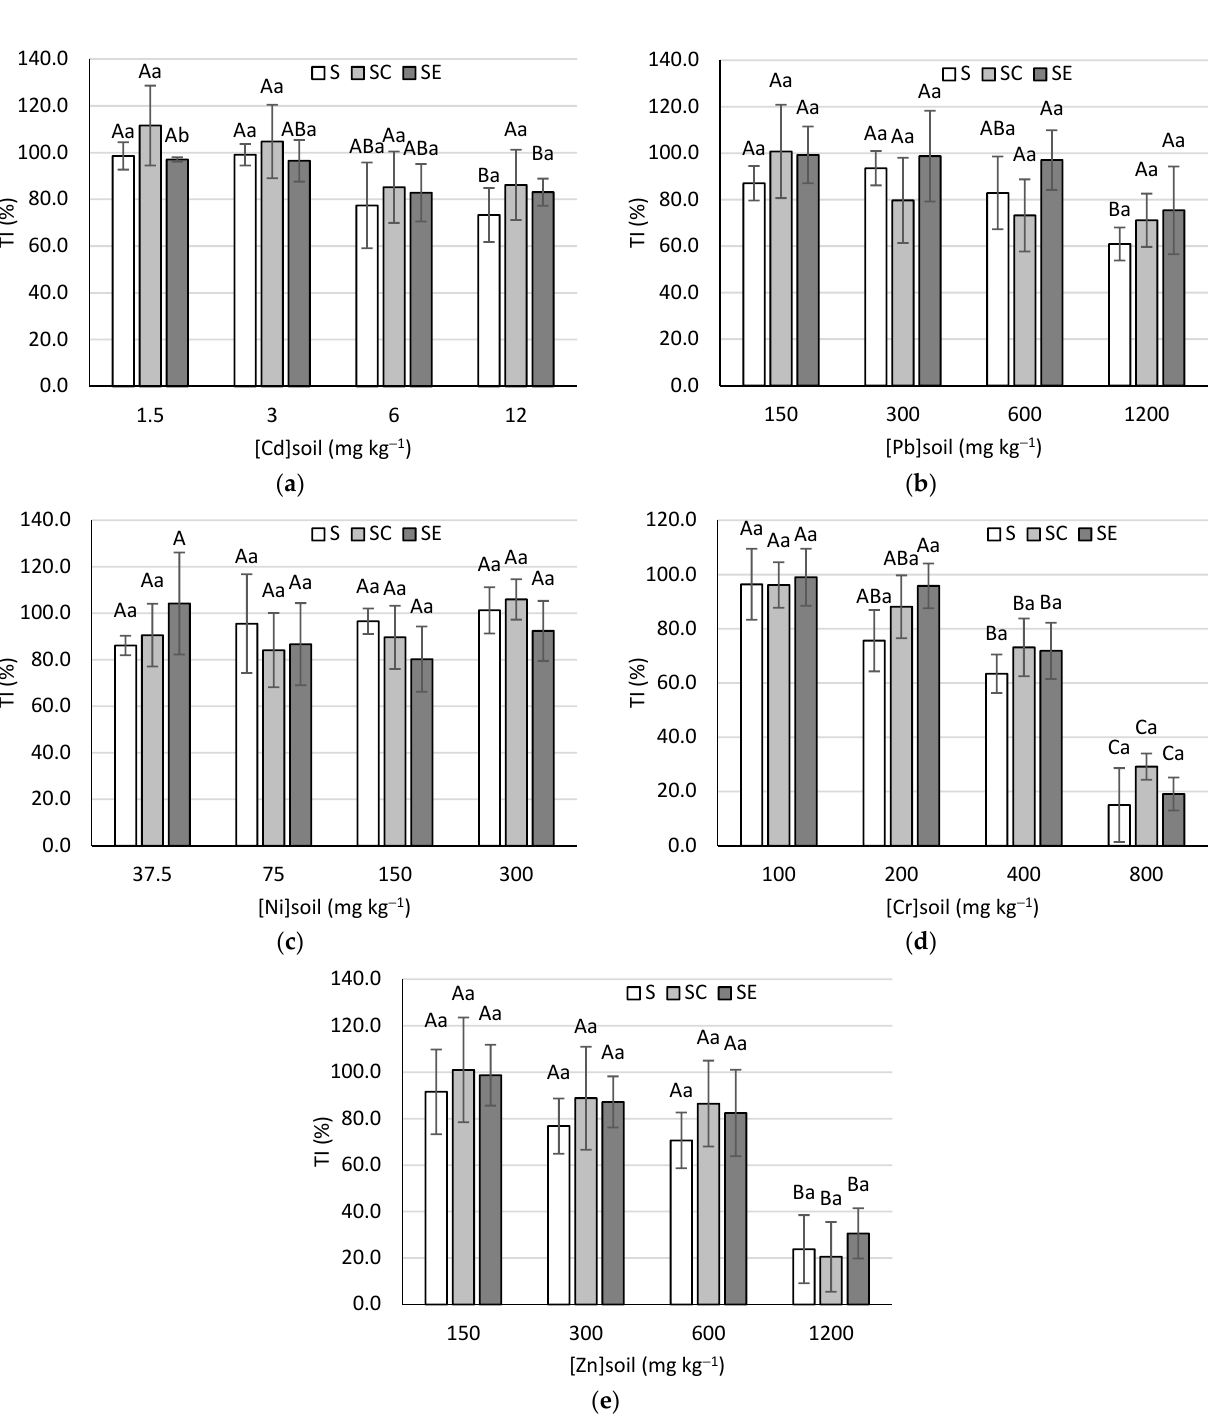
Figure 3. Tolerance Index (TI) for each PTE and each treatment, non-amended soil (S), soil amended with cork powder (SC) and soil amended with horse manure (SE): ( a ) Cd; ( b ) Pb; ( c ) Ni; ( d ) Cr; ( e ) Zn.